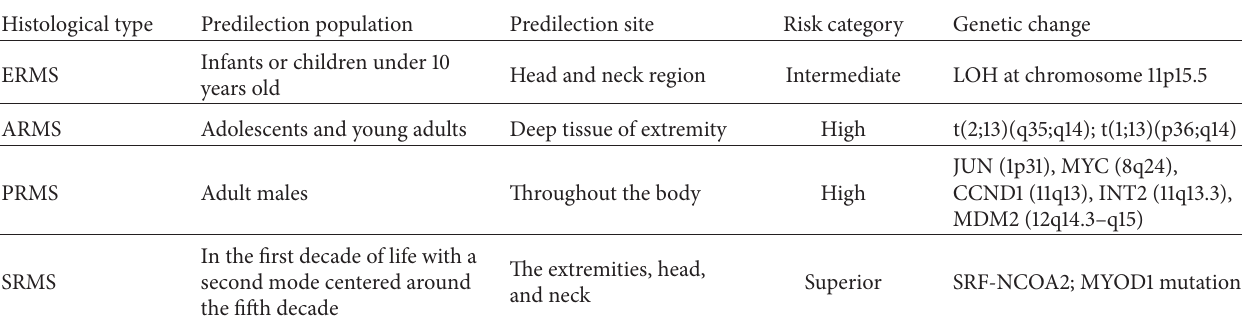
Table 2: The histological types of